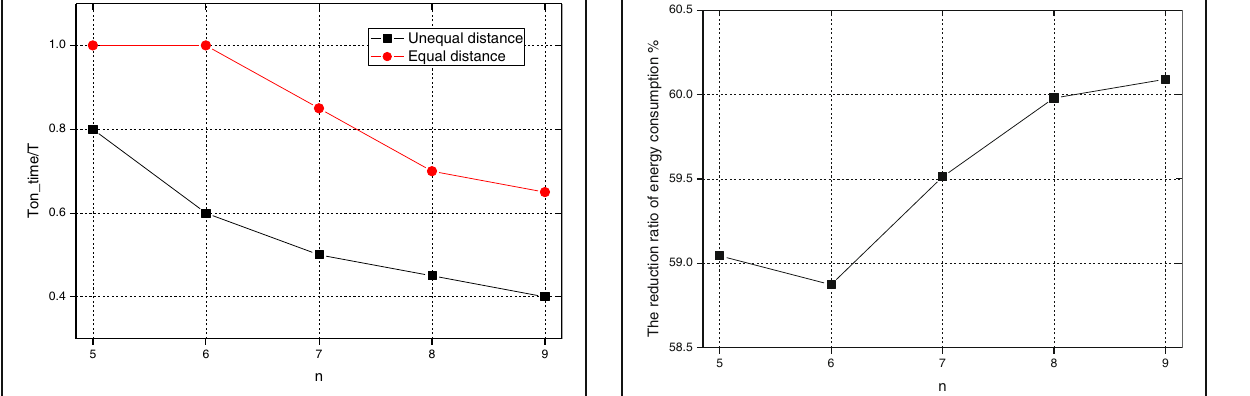
number of nodes when both strategies adopt an optimal duty cycle. Figure 10 shows the optimal duty cycle of UDNP and EDNP in the linear network with n nodes, where the horizontal axis represents the number of nodes in the network and the vertical axis represents the optimal duty cycle. Figure 11 shows the maximum energy consump- tion of all nodes in the network when both strategies are